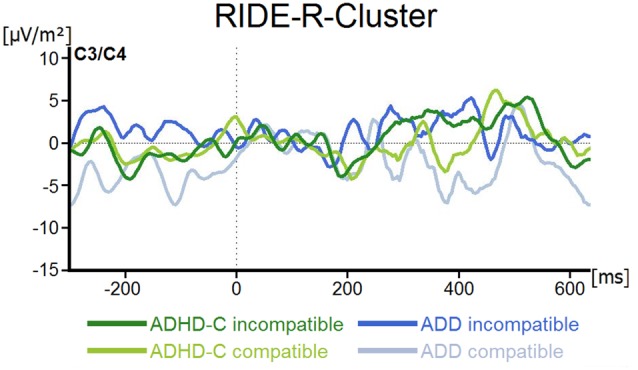
R-Cluster RIDE-component depicted for both ADHD subtypes and for compatible and incompatible flanker trials at electrodes C3/C4. Point 0 denotes the onset of the target stimulus.